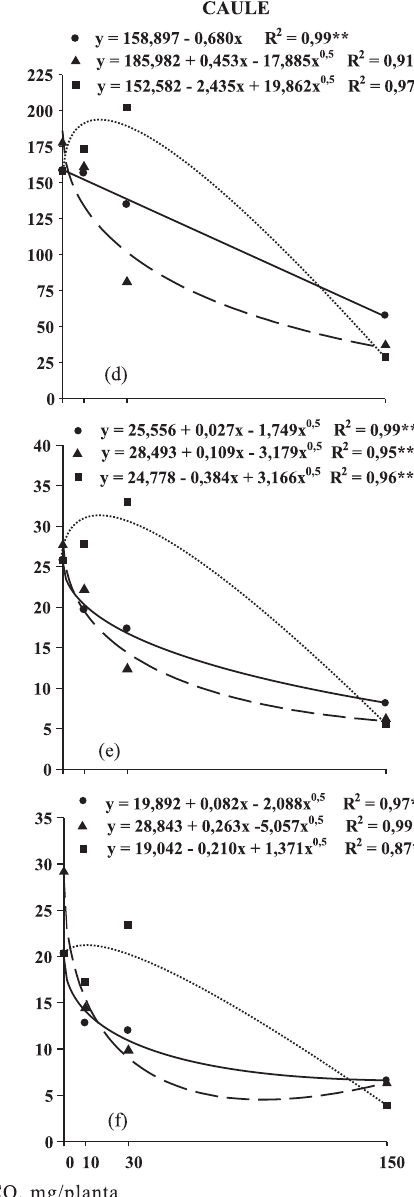
Figura 6. Acúmulo de Ca, Mg e S na matéria seca das folhas (a, b, c) e do caule (d, e, f) de mudas de eucalipto, em resposta ao aumento de concentrações de C-ácido húmico em solução nutritiva. AH p.a.: ácido húmico p.a.; MH: material húmico; AC: ácido cítrico; AO: ácido